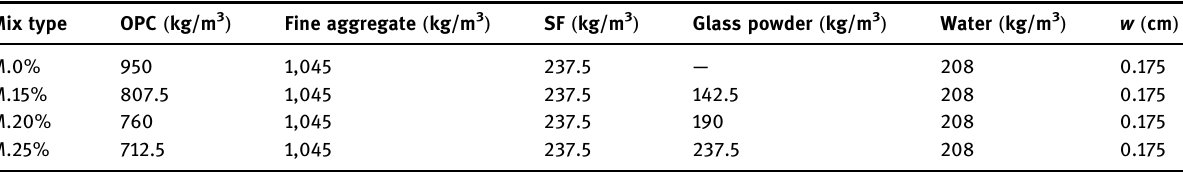
Table 3: Details of mix proportion for SRPC